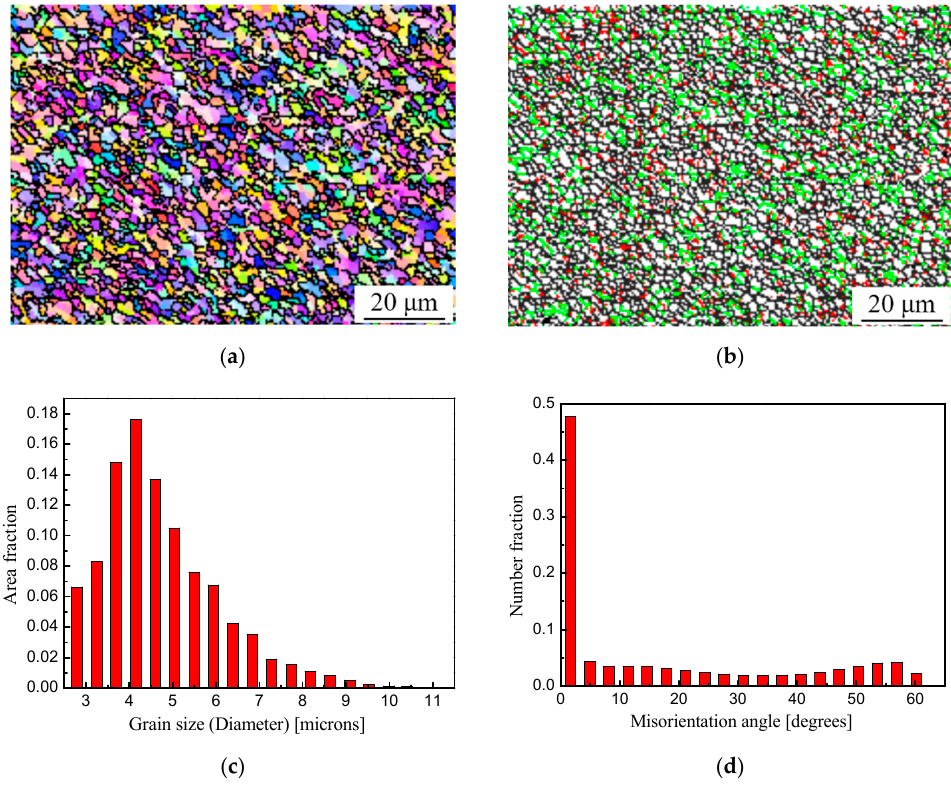
Figure 9. EBSD analysis of stir zone using process parameters: rotating speed 1600 rpm, plunge rate 72 mm/min, plunge depth 2.2 mm, and dwell time 3 s: ( a ) grain shape; ( b ) EBSD boundary map; ( c ) area fraction of grain size; ( d ) number fraction of misorientation angle.